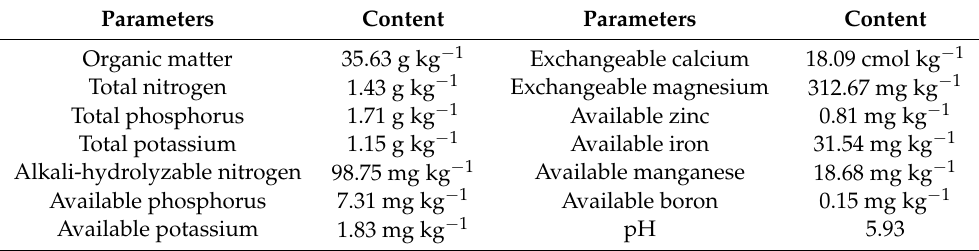
Table 2. The physical and chemical characteristics of planting soils in the kiwifruit orchard. Parameters Content